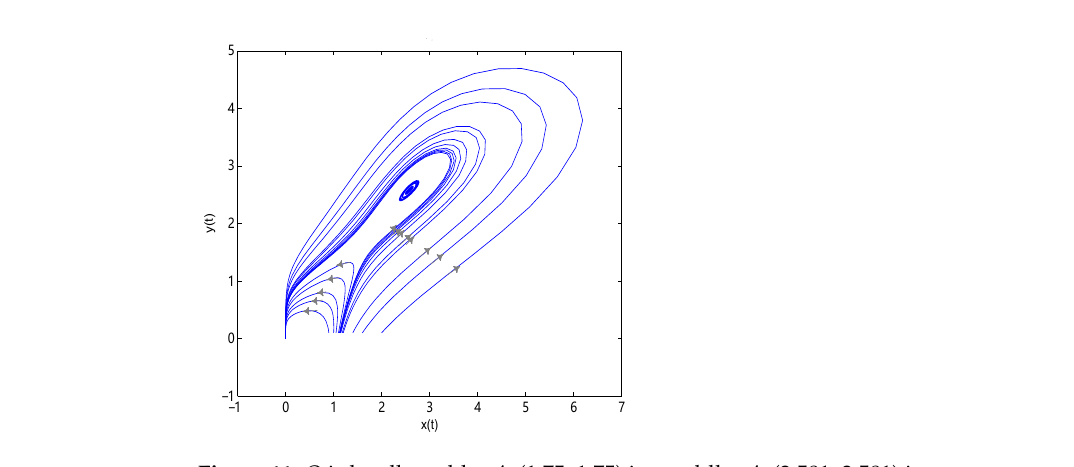
Figure 11. O is locally stable. A 2 (1.75, 1.75) is a saddle. A 3 (2.581, 2.581) is a center-type equilibrium point. In here r = 2, ω = 0.414, b = 0.5, c = 2.87, α = 0.78.